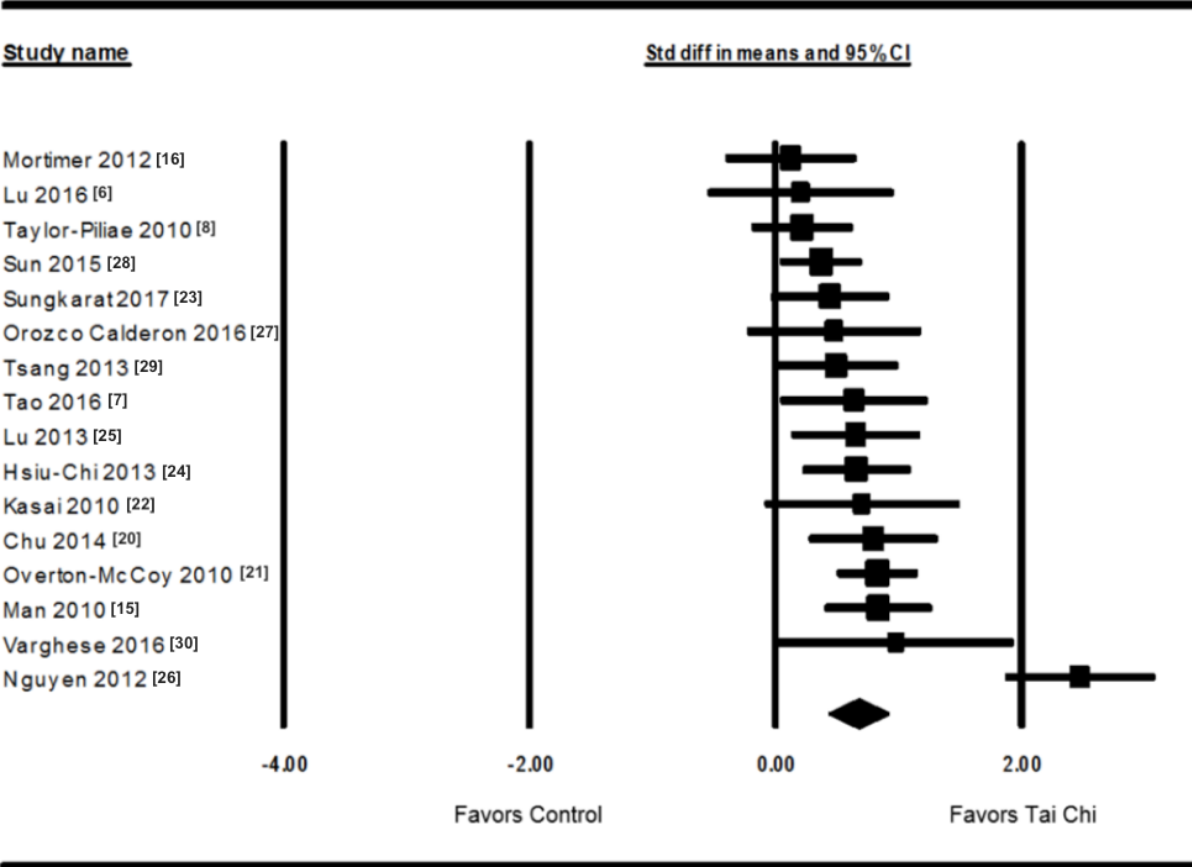
Figure 2. Forest plot of effect sizes (ESs) from the 16 studies that assessed the effect of Tai Chi on cognitive function (Tai Chi group vs. control group).